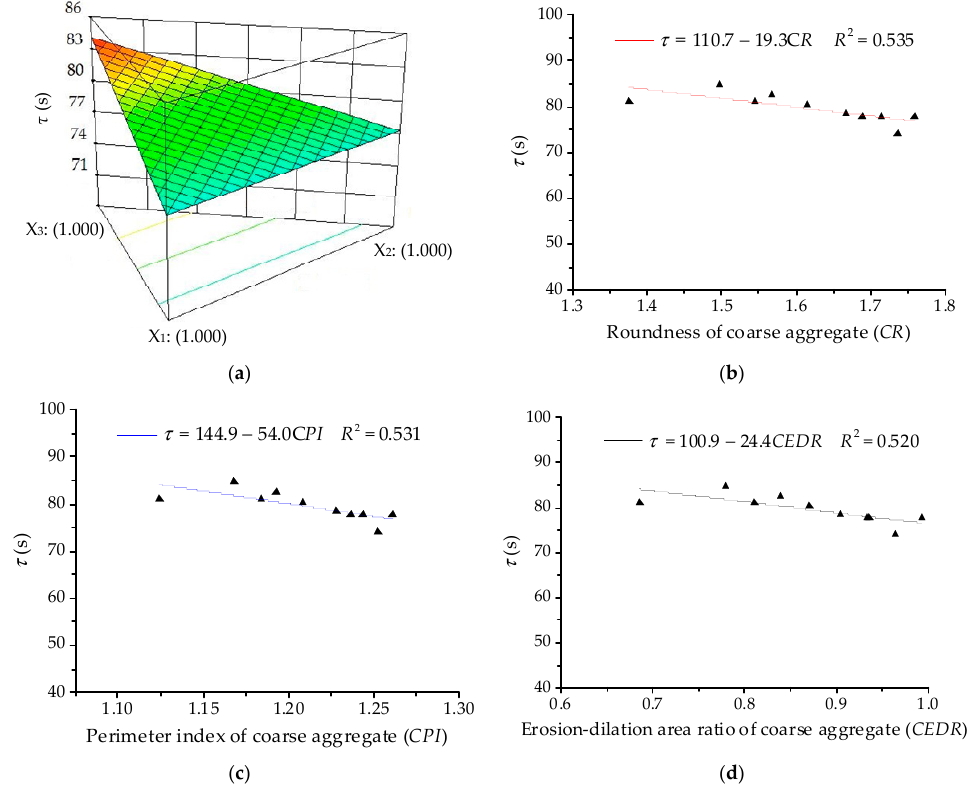
Figure 13. Relationships between τ and coarse aggregates: ( a ) Response surface plot for component proportion and τ ; ( b ) CR and τ ; ( c ) CPI and τ ; ( d ) CEDR and τ .